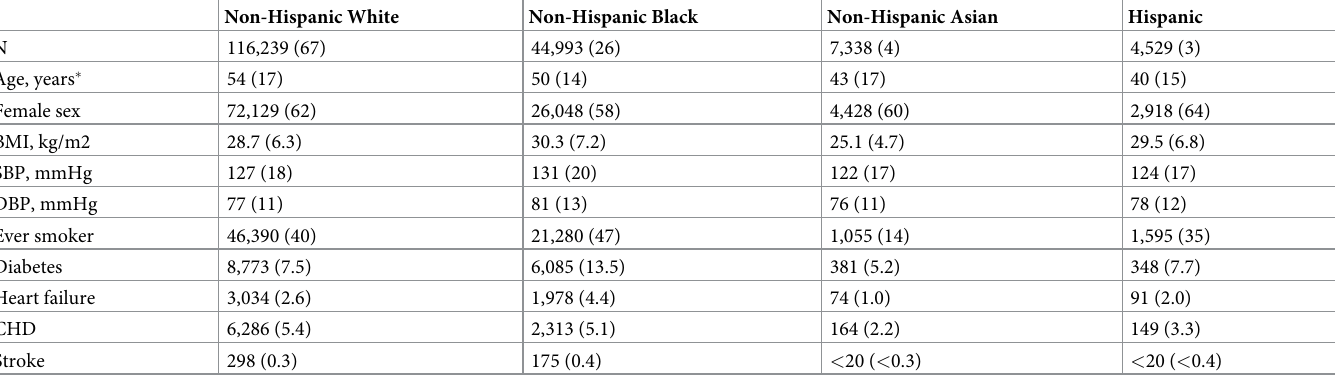
Table 1. Participant characteristics by race/ethnicity. Values correspond to mean (standard deviation) or N (%), All of Us Research Program,